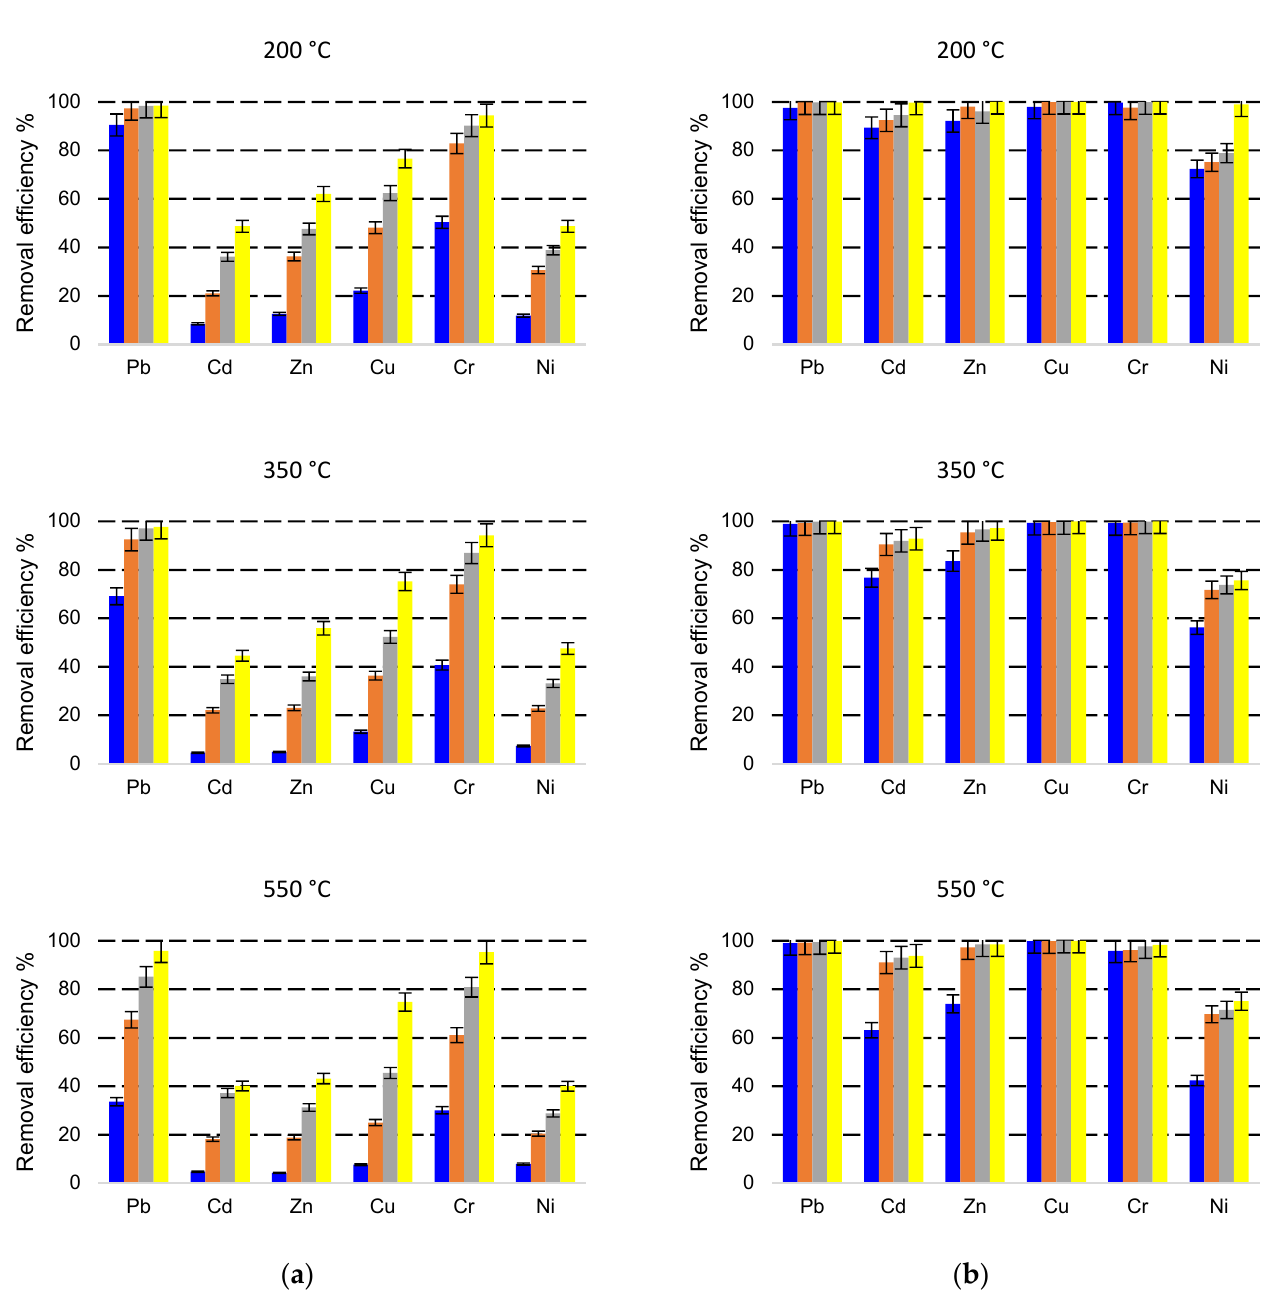
Figure 2. Simultaneous removal of Pb, Cd, Zn, Cu, Cr, Ni with NZ1 ( a ) and NZ2 ( b ) thermally treated at 200 °C, 350 °C, and 550 °C from a multicomponent solution of 5 mg L − 1 at four different contact times (5 min—blue, 10 min—orange, 30 min—grey, 60 min—yellow).